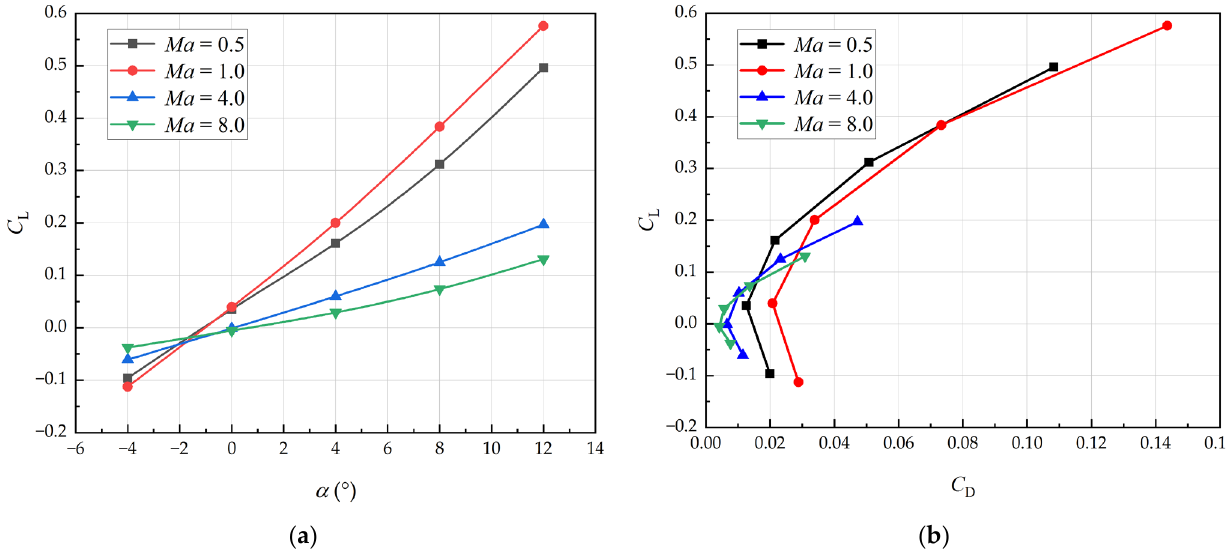
Figure 7. Lift and drag coefficients for the illustrative aircraft. ( a ) Lift curve; ( b ) lift-to-drag polar.